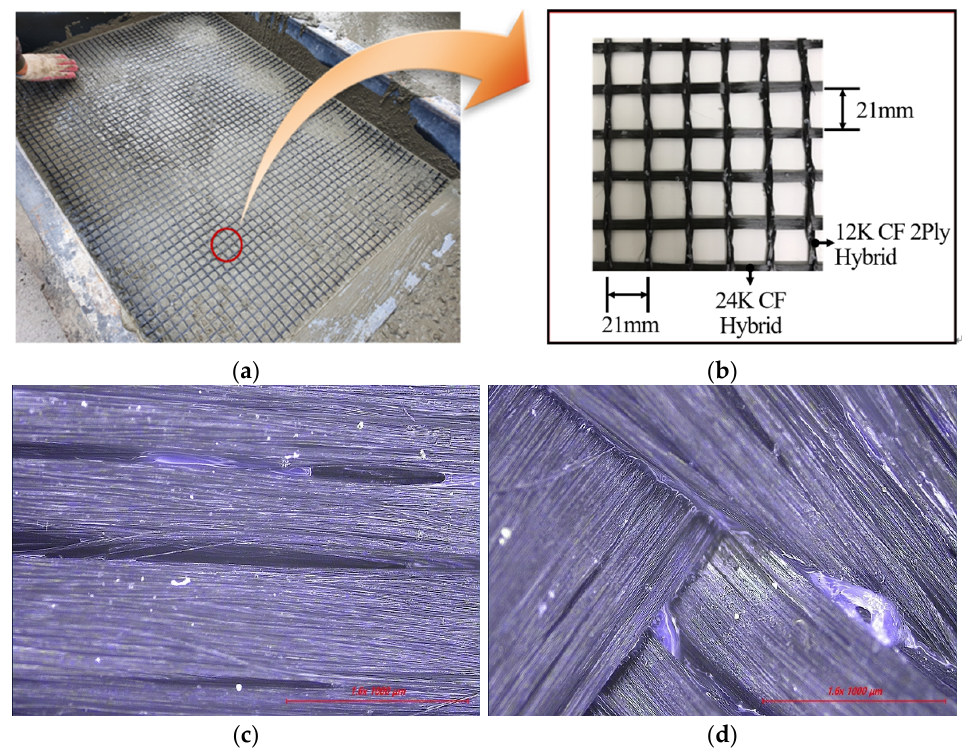
Figure 2. Carbon fiber grid. ( a ) Specimen. ( b ) Detail of carbon fiber grid. ( c ) MD direction. ( d ) CD direction.